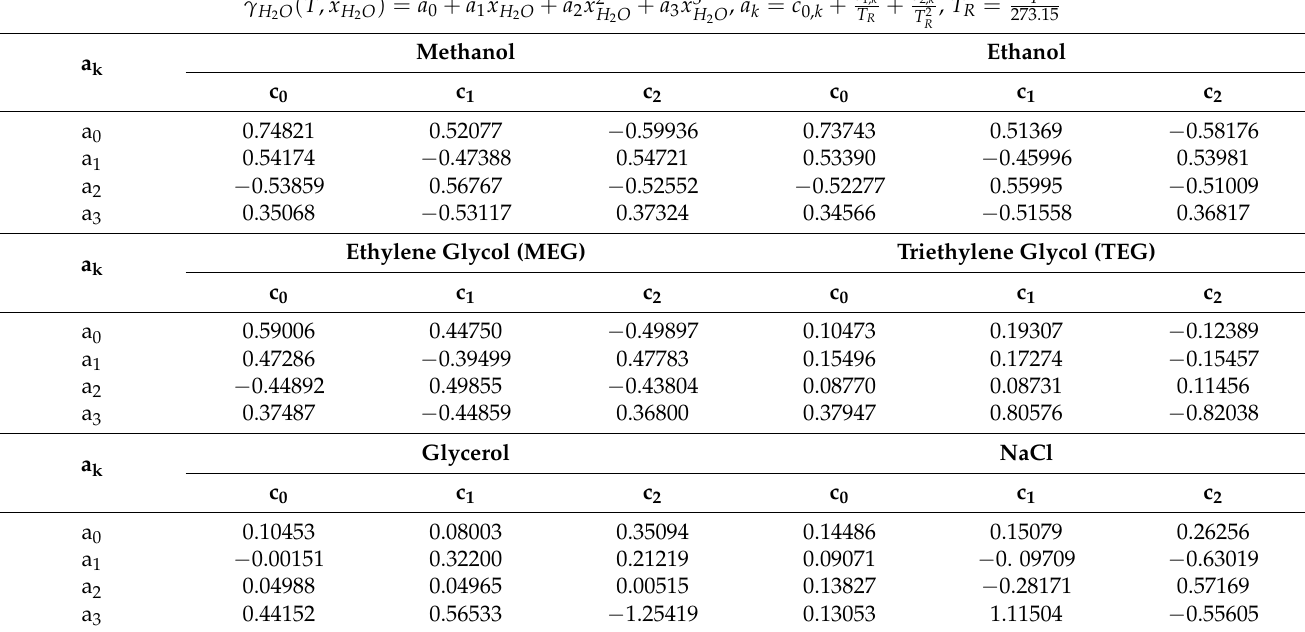
Table A1. Model and parameters for water activity coefficients (row 3, last column in Table